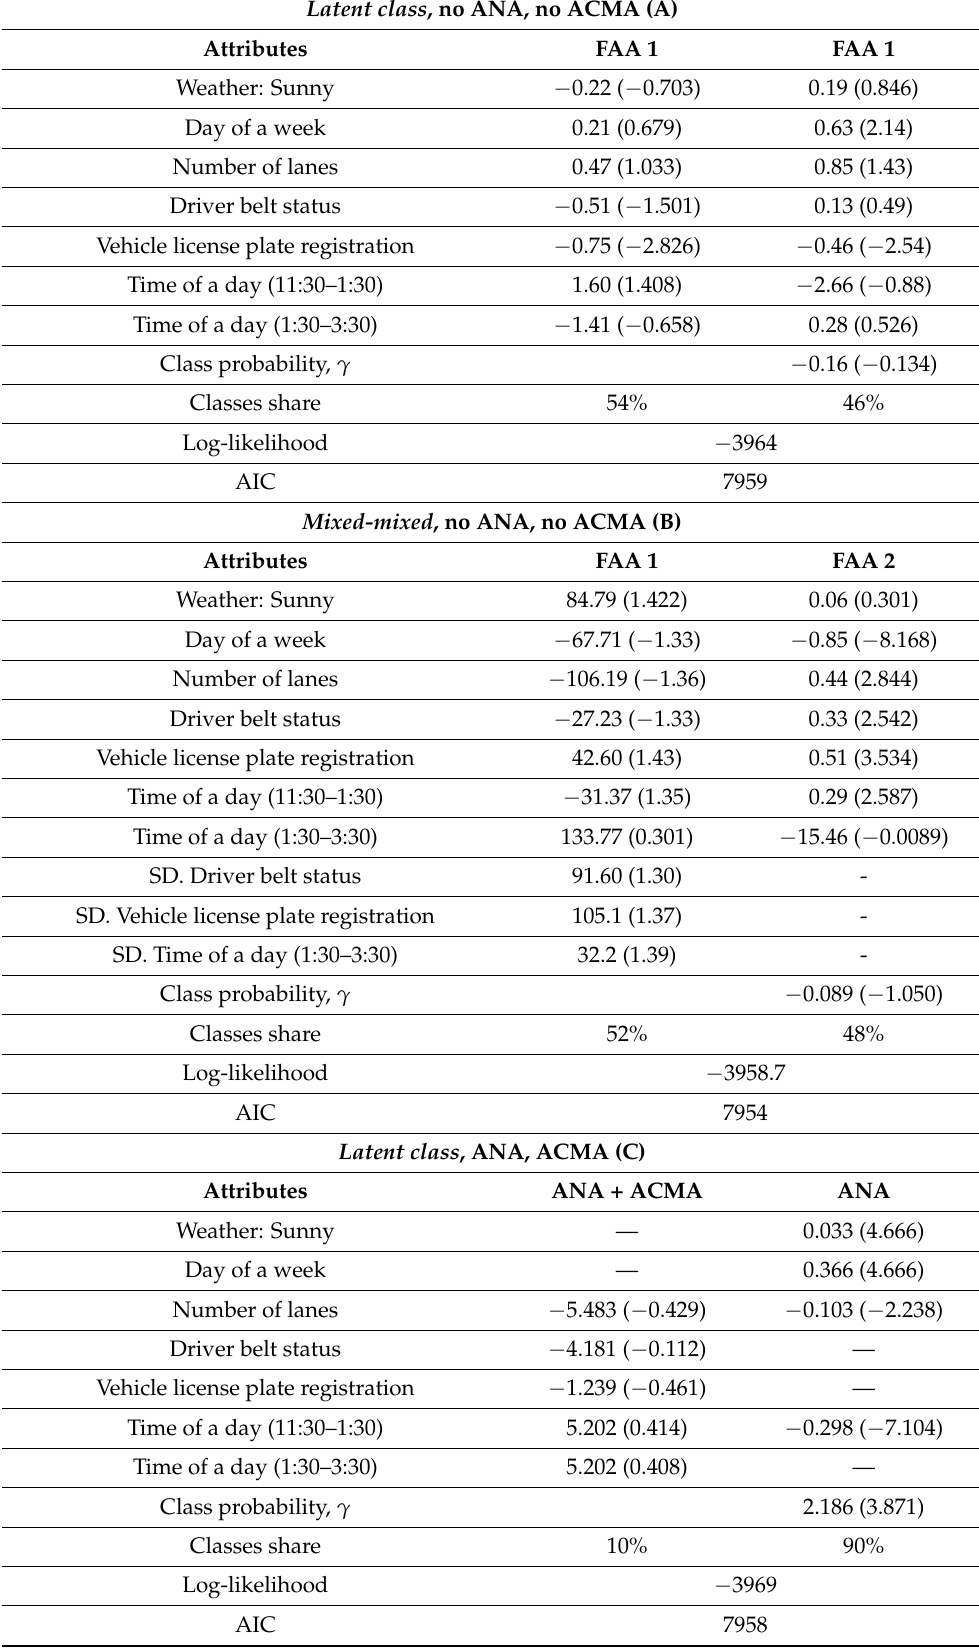
Table 2. Summary of the models, t-ratio in